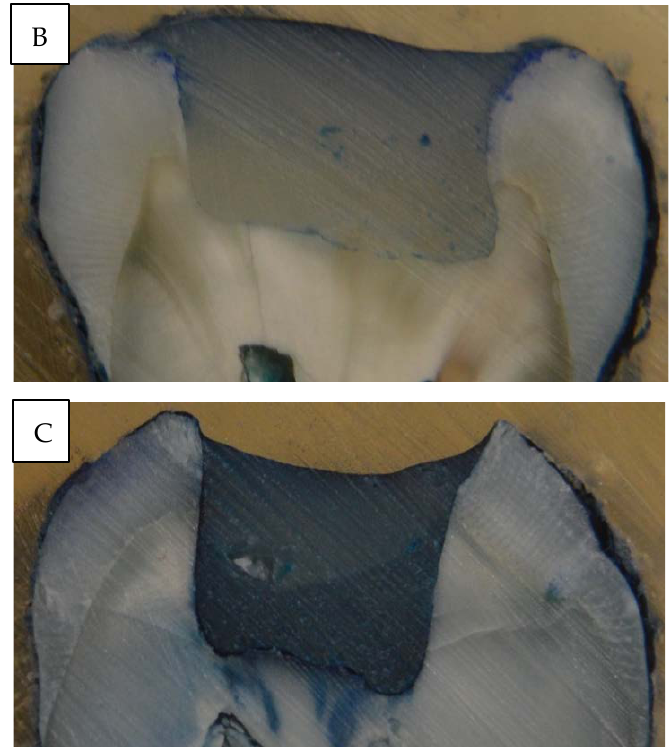
Figure 3. Pictures ( A – C ) of the sectioned specimen after dye penetration analysis. Picture ( A ) showed minimal to no marginal staining, while the other pictures show moderate (Picture ( B )) to deep (Picture ( C )) penetration of the dye, starting from the margins.